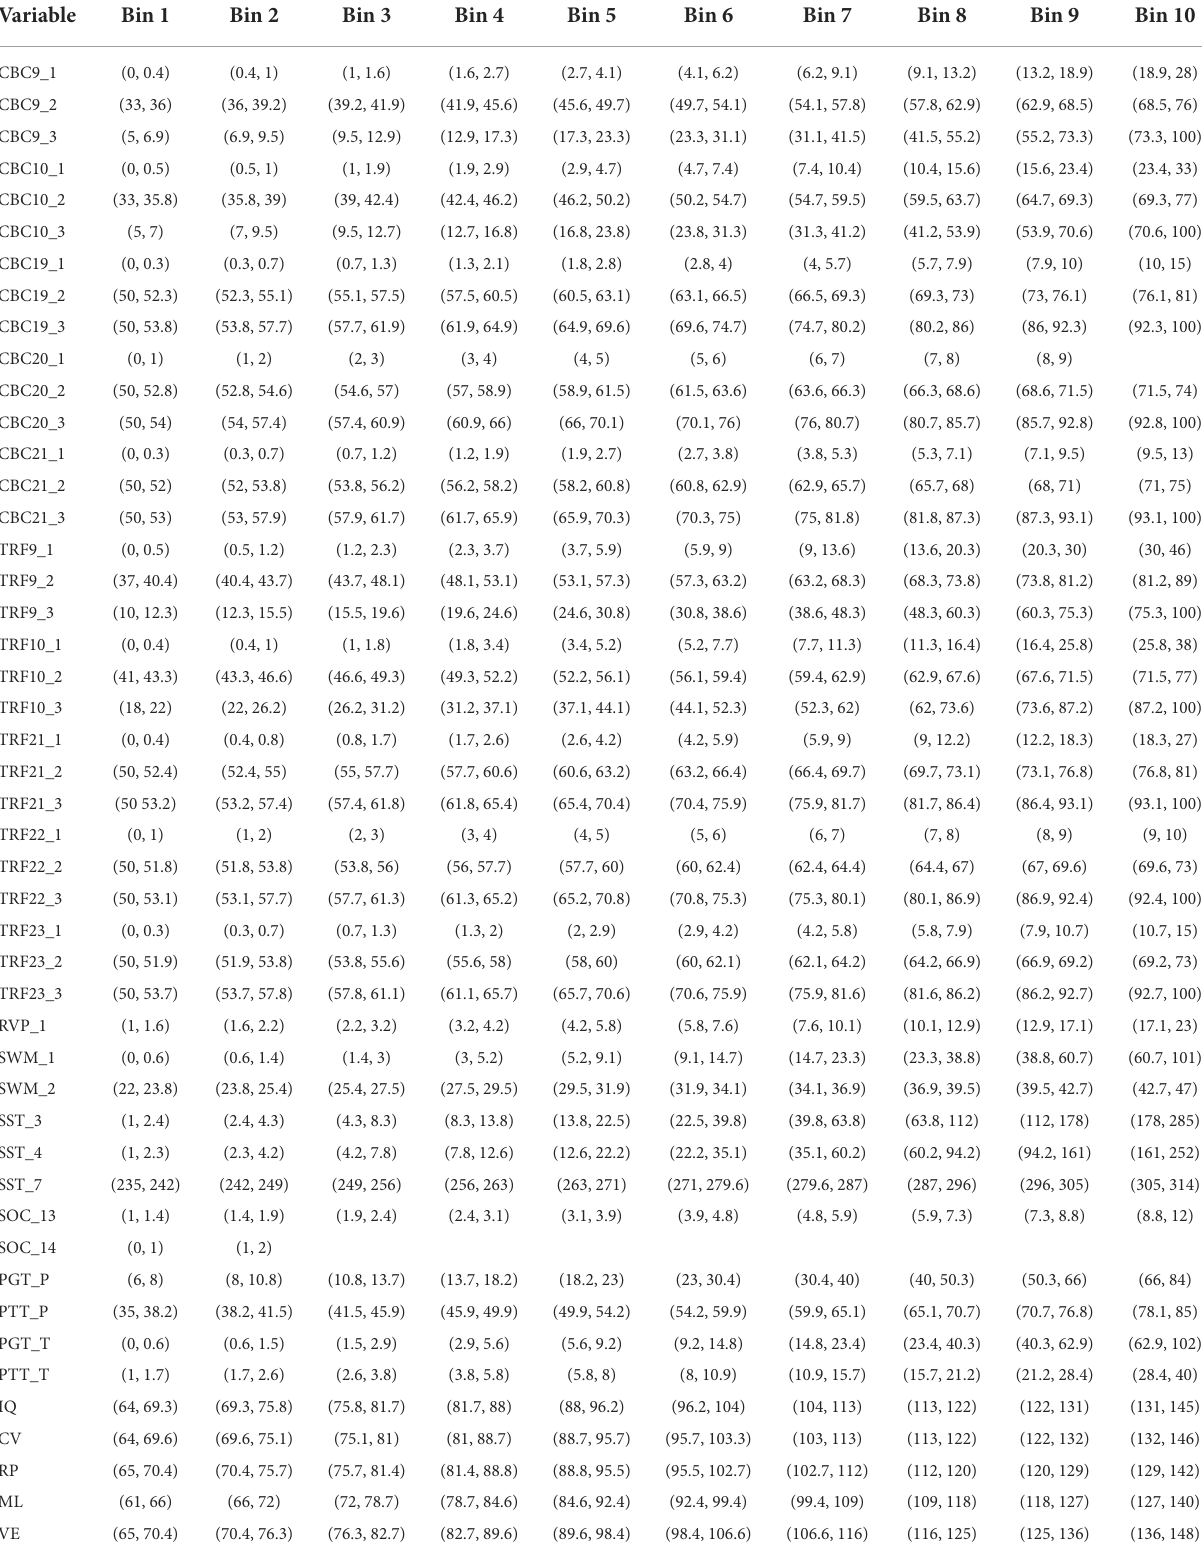
TABLE 3 Conversion of continuous variables into categorical